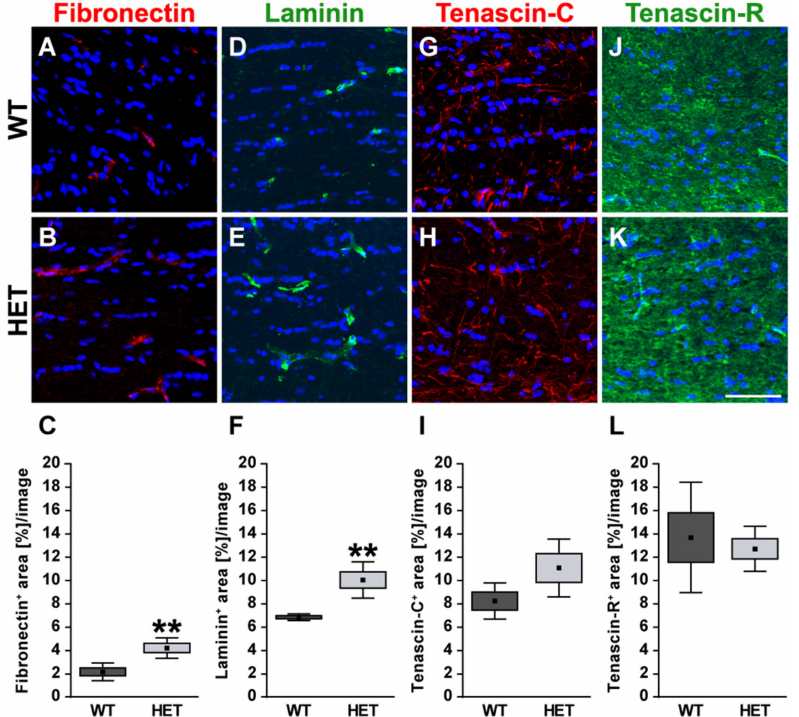
Figure 5. Enhanced staining signals of blood vessel-associated fibronectin and laminin in the glau- comatous optic nerve of HET mice. Most representative immunohistochemical ECM stainings are shown. Staining of the glycoproteins fibronectin (red; ( A – C )) and laminin (green; ( D – F )) was signifi- cantly increased in the HET optic nerves. Signals were limited to blood vessels. A thread-like-staining pattern was found for tenascin-C (red; ( G , H )), while a widely extracellular staining pattern was observed for tenascin-R (green; ( J , K )). Both tenascins showed a comparable staining area in the WT and HET group ( I , L ). Groups were analyzed by Student‘s t -test. Data are shown as mean ± SEM ± SD. ** p < 0.01. n = 5/group. Scale bar = 50 µ